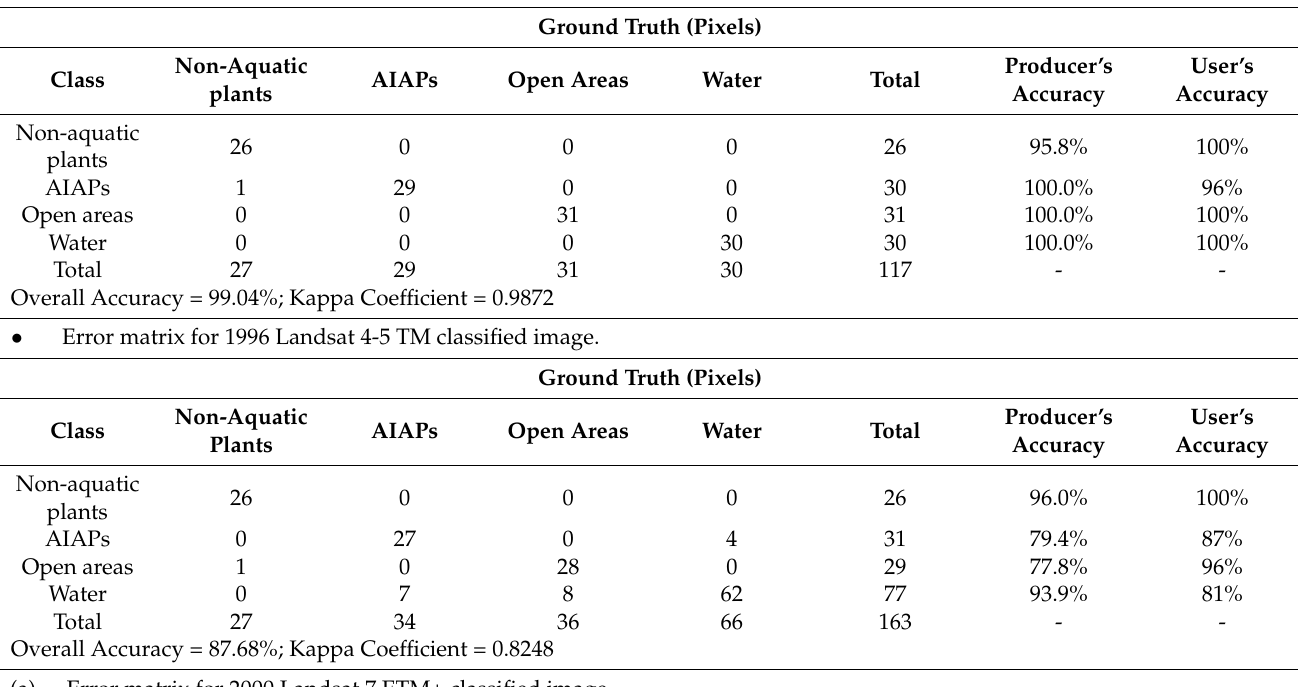
Table 3. Results of accuracy assessment (confusion matrix of land use/cover maps of 1992, 1996, 2000, 2003, 2007, 2010, 2013, 2016, 2017, and 2019. • Error matrix for 1992 Landsat 4-5 TM classified image